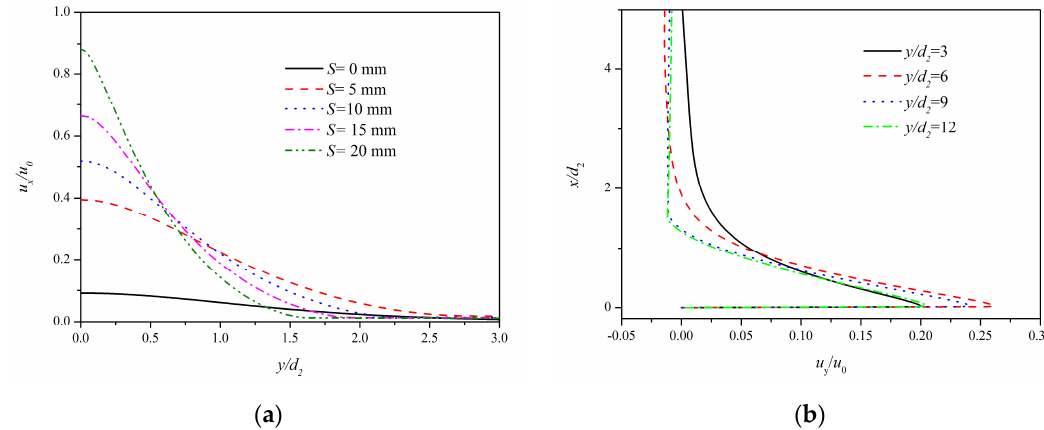
Figure 8. ( a ) Non-dimensional velocity magnitude at different axial locations ( b ) Non-dimensional velocity magnitude at different radial locations.